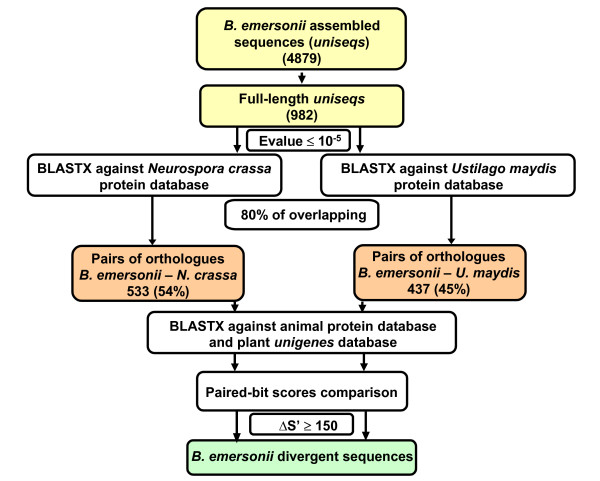
Overview of the pipeline used in the EST comparative study, approach 2. B. emersonii putative full-length uniseqs were compared against fungal protein sequences from N. crassa and U. maydis, and orthologous pairs were compared against animal and plant databases. See Methods section for details.